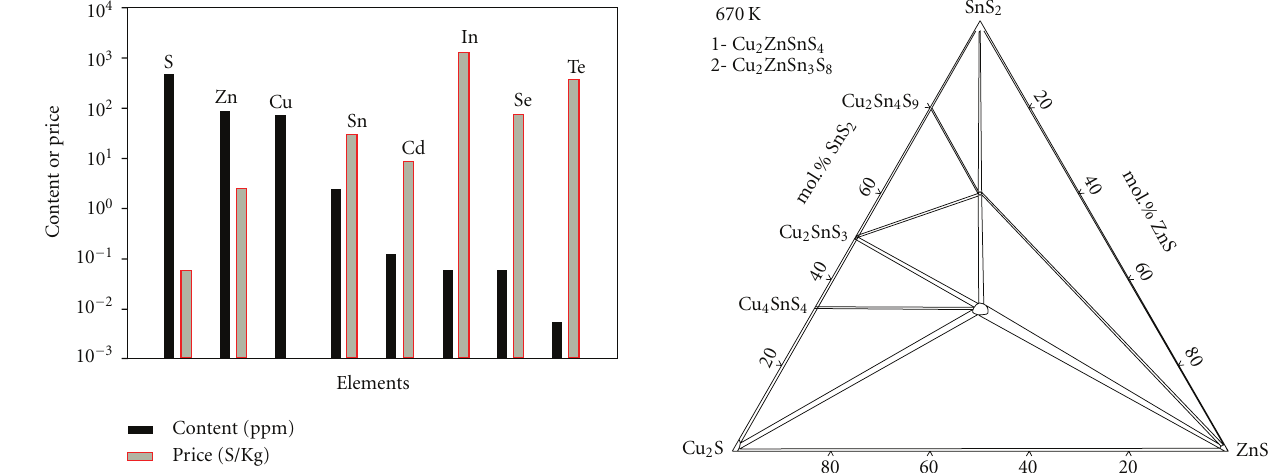
Figure 1: Content and the world trading price of the elements used in light absorbers CdTe, Cu 2 ZnSnS 4 , CuInSe 2 for thin film solar cells. Figure 2: Phase diagram of SnS-Cu 2 S-ZnS solar cells (taken from